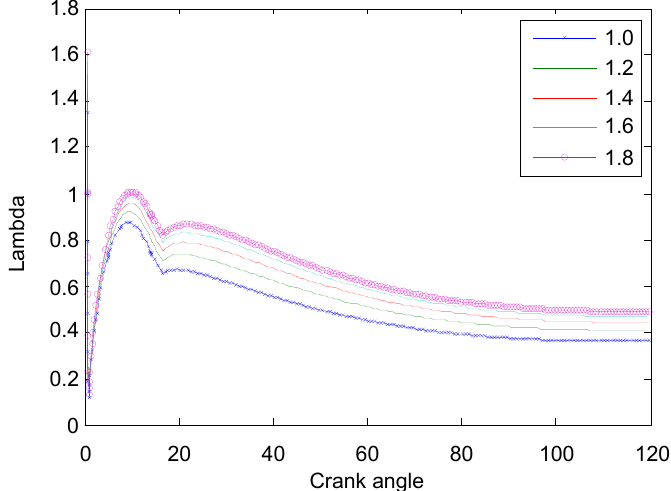
Energies 2019 , 12 , x FOR PEER REVIEW Figure 7. Curves of the value of λ with di ff erent values of ξ . Figure 7. Curves of the value of 𝜆 with different values of 𝜉 . Figure 7. Curves of the value of 𝜆 with different values of 𝜉 .